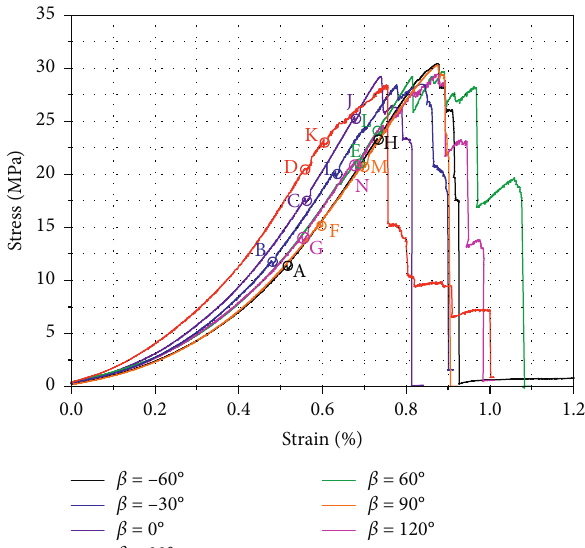
Figure 12: The stress-strain curve of sandy mudstone specimens for different dips of the rock bridge with main flaw ( β ).